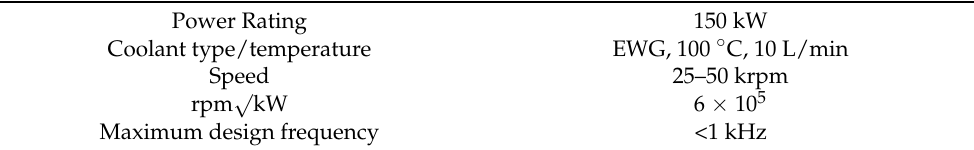
Table 3. Requirements for marine EAT (Electrically Assisted Turbocharger) machine for a diesel